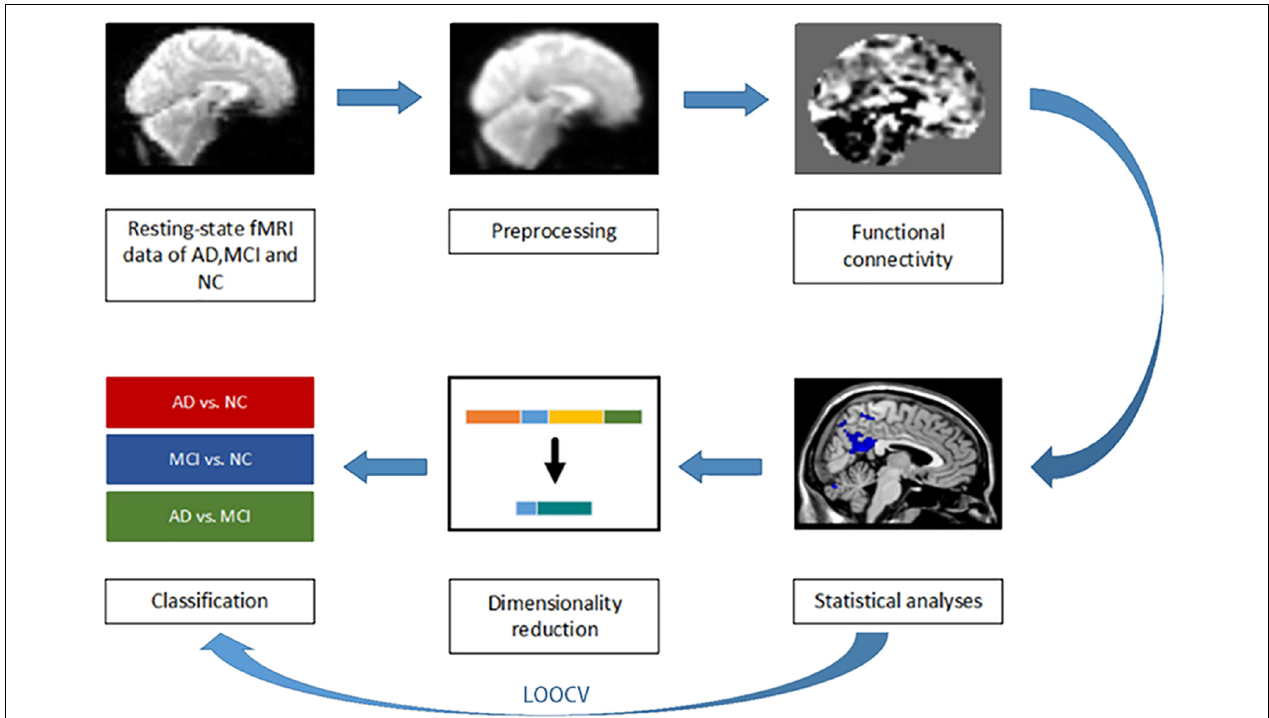
FIGURE 1 | A preprocessing, feature extraction, and classification framework.